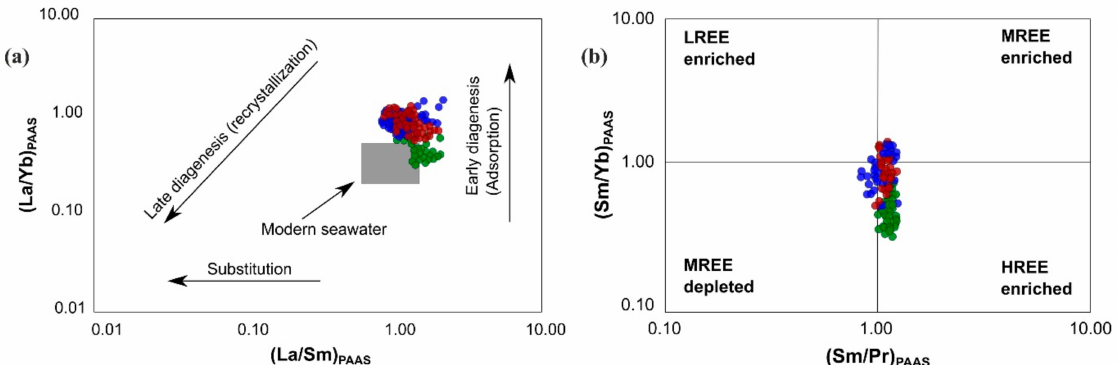
Figure 11. ( a ) The (La/Sm) PAAS vs. (La/Yb) PAAS binary plot showing the influence of diagenesis to studied phosphorite samples grouped by location. Red circles are for the Algeria deposits, blue circles are for the Tunisia deposits, green circles are for the Morocco deposits. ( b ) The (Sm/Pr) PAAS vs. (Sm/Yb) PAAS diagram displaying the HREE enrichment recorded in the Africa deposits. Symbols are as in ( a